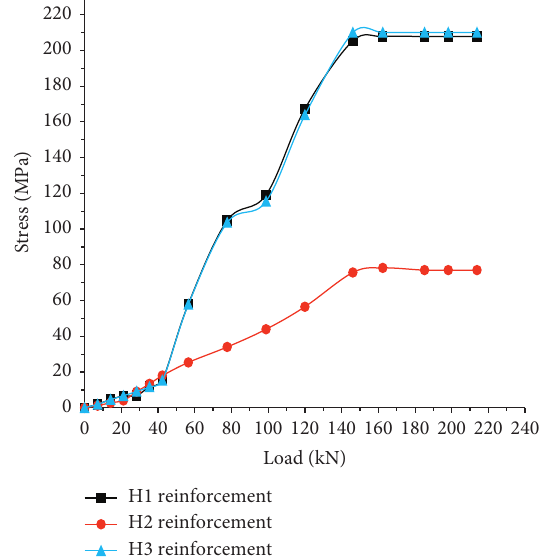
Figure 18: Stress/load curves of the LPCSHTHSC truss bars in the midspan section along the short-span